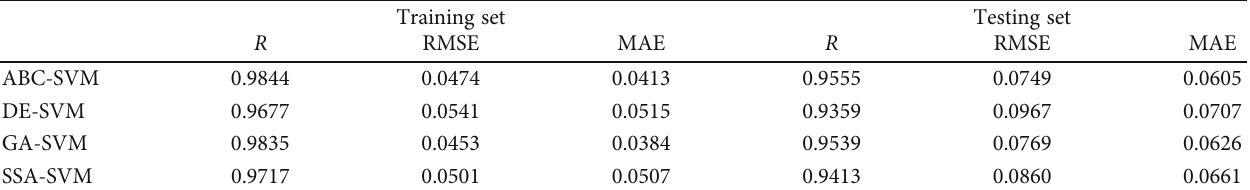
Table 3: The performance indicators of di ff erent prediction